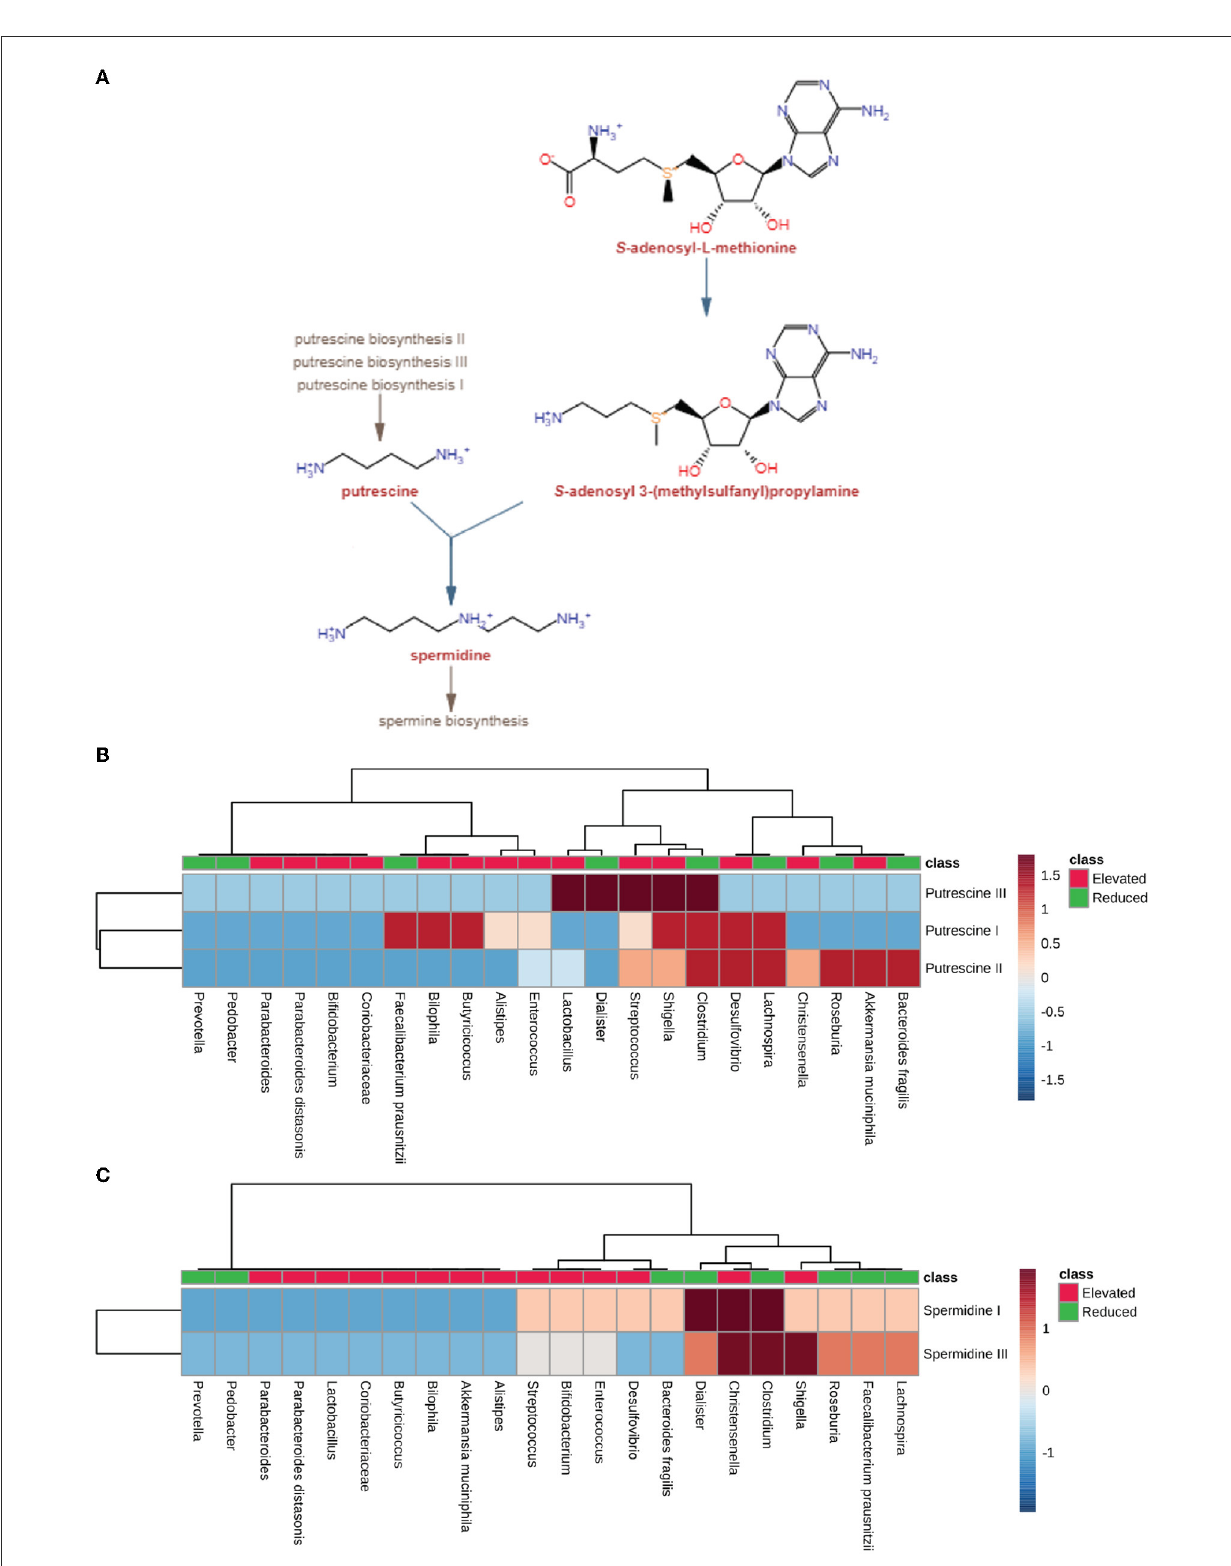
FIGURE6 Polyamine synthesis pathway analysis. (A) Pathway for producing polyamine, including spermidine and putrescine, by using S-adenosyl-3(methylsulfonyl) as a precursor molecule by gut microbiota. (B) Heatmap showing pathway scores of putrescine synthesis in microbes found in elevated and reduced conditions in AD, PD, MS, and ALS. (C) Heatmap showing pathway scores of spermidine synthesis in microbes found in elevated and reduced conditions in AD, PD, MS, and